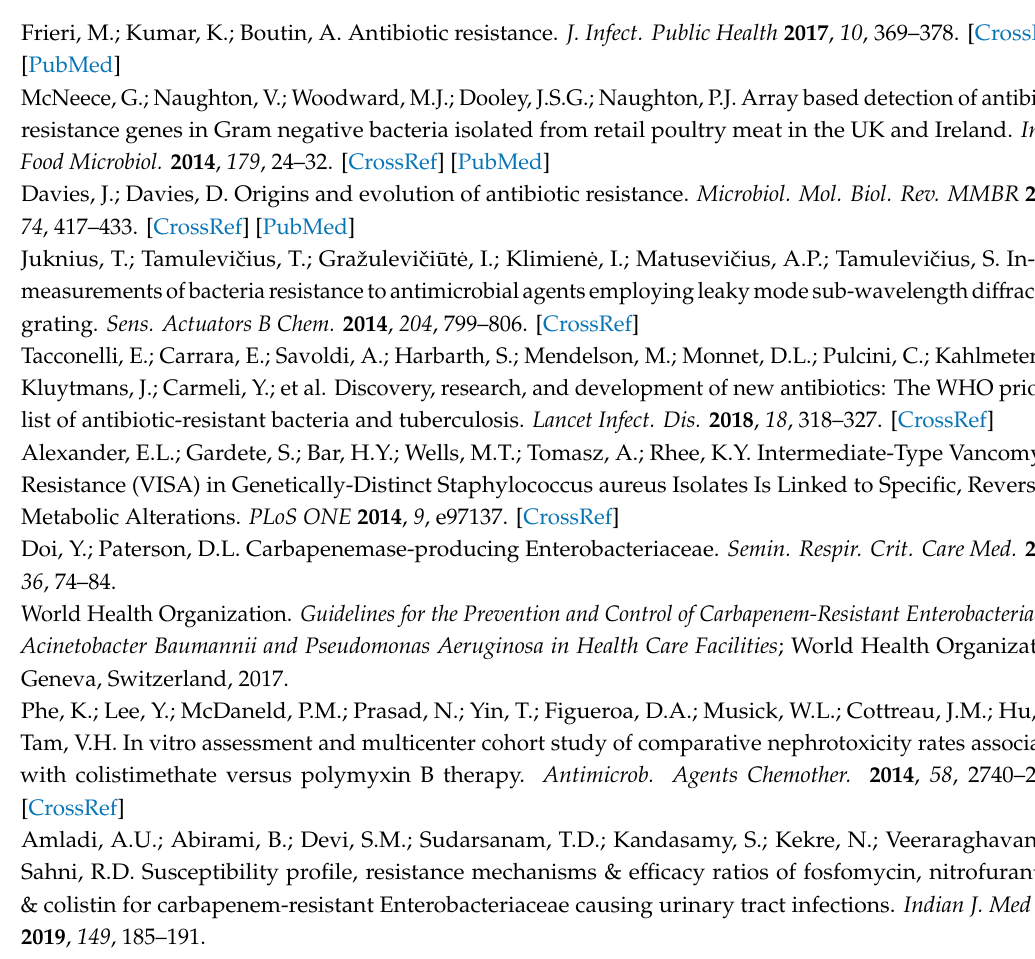
Figure S1: Growth curve and viability percentage in presence of HSER, Figure S2: Growth curve and viability percentage in presence of CQDs, Figure S3: ROS, Figure S4: Optical image of VRSA and E. coli , Figure S5: The cytotoxicity